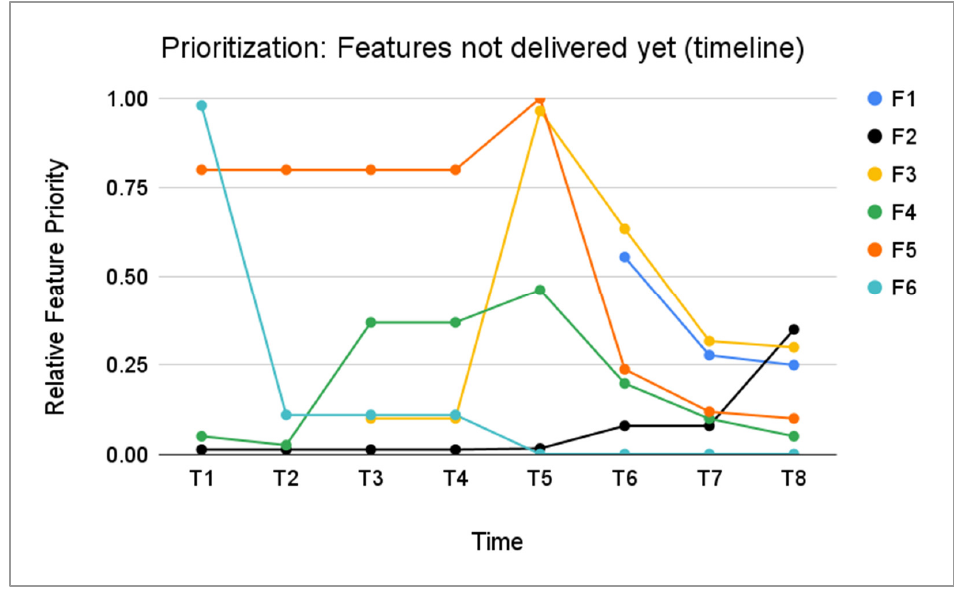
Figure 2. Product roadmap: planned features.